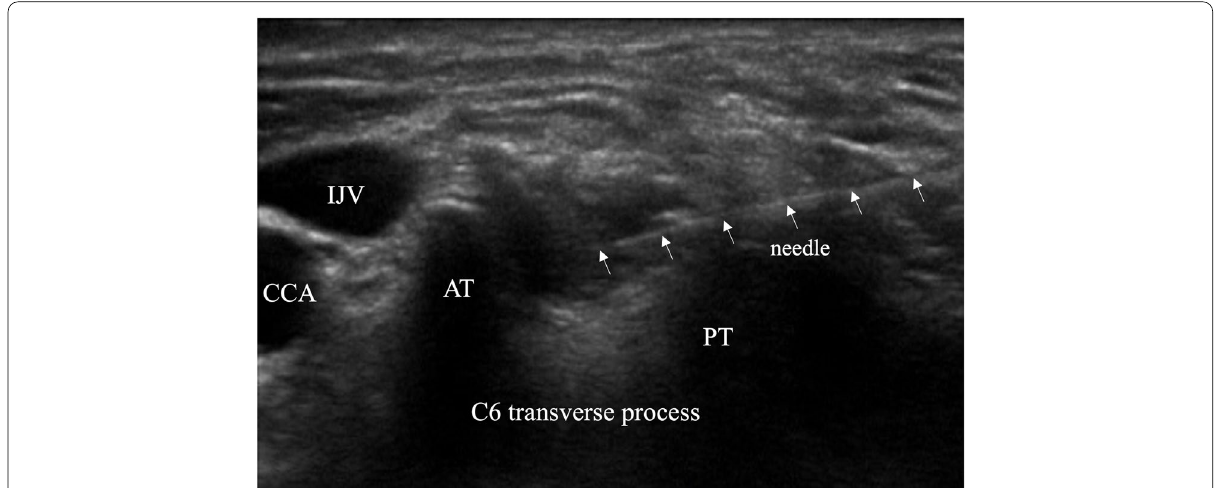
Fig. 2 An ultrasound image of cervical selective nerve root injection. A needle (white arrow) is visualized on the right side of the image toward the C6 intervertebral foramina AT, anterior tubercle; CCA, common carotid artery; IJV, internal jugular vein; PT, posterior